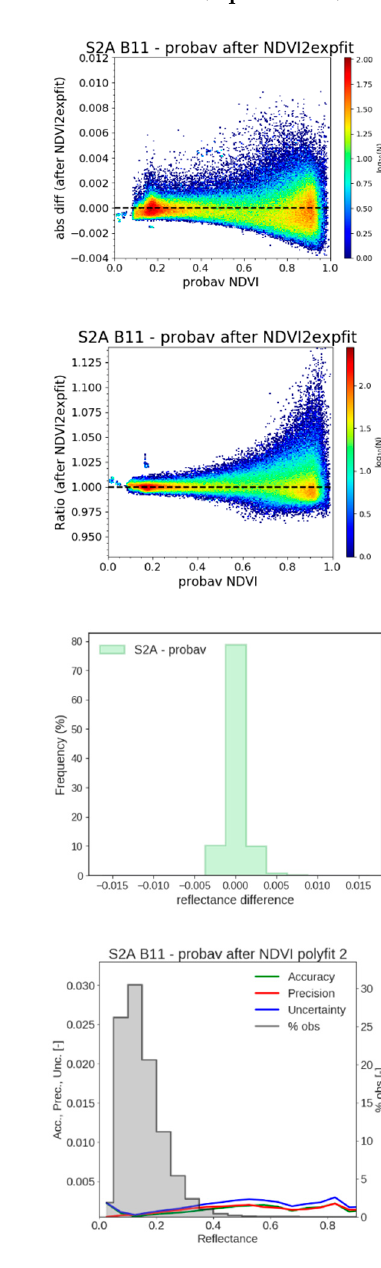
Figure 3. Comparison between the SWIR band of PROBA-V and B11 of S2A, original data ( left ), and after applying the best correction functions AD_NDVIpoly2 ( right ). Top row: AD between PROBA-V SWIR and S2A B11 versus NDVI of PROBA-V, second row: ratio between PROBA-V SWIR and S2A B11 versus NDVI of PROBA-V, third row: bias histogram between PROBA-V SWIR and S2A B11, and bottom row: APU-plot between PROBA-V SWIR and S2A B11.